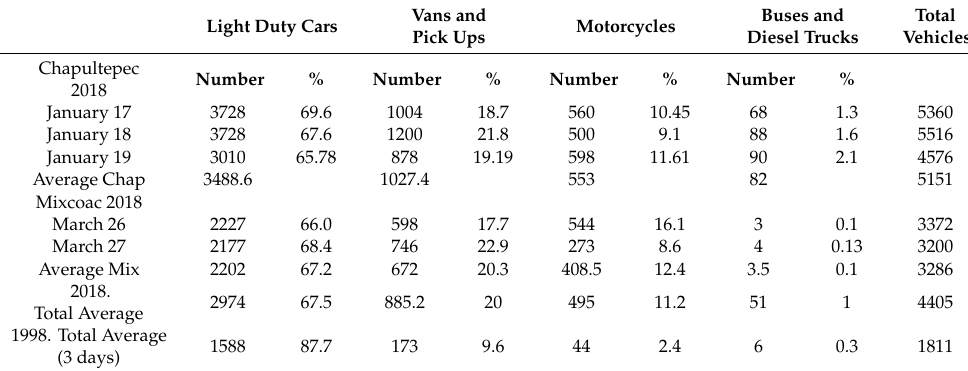
Table 1. Characteristics of the vehicular fleet.